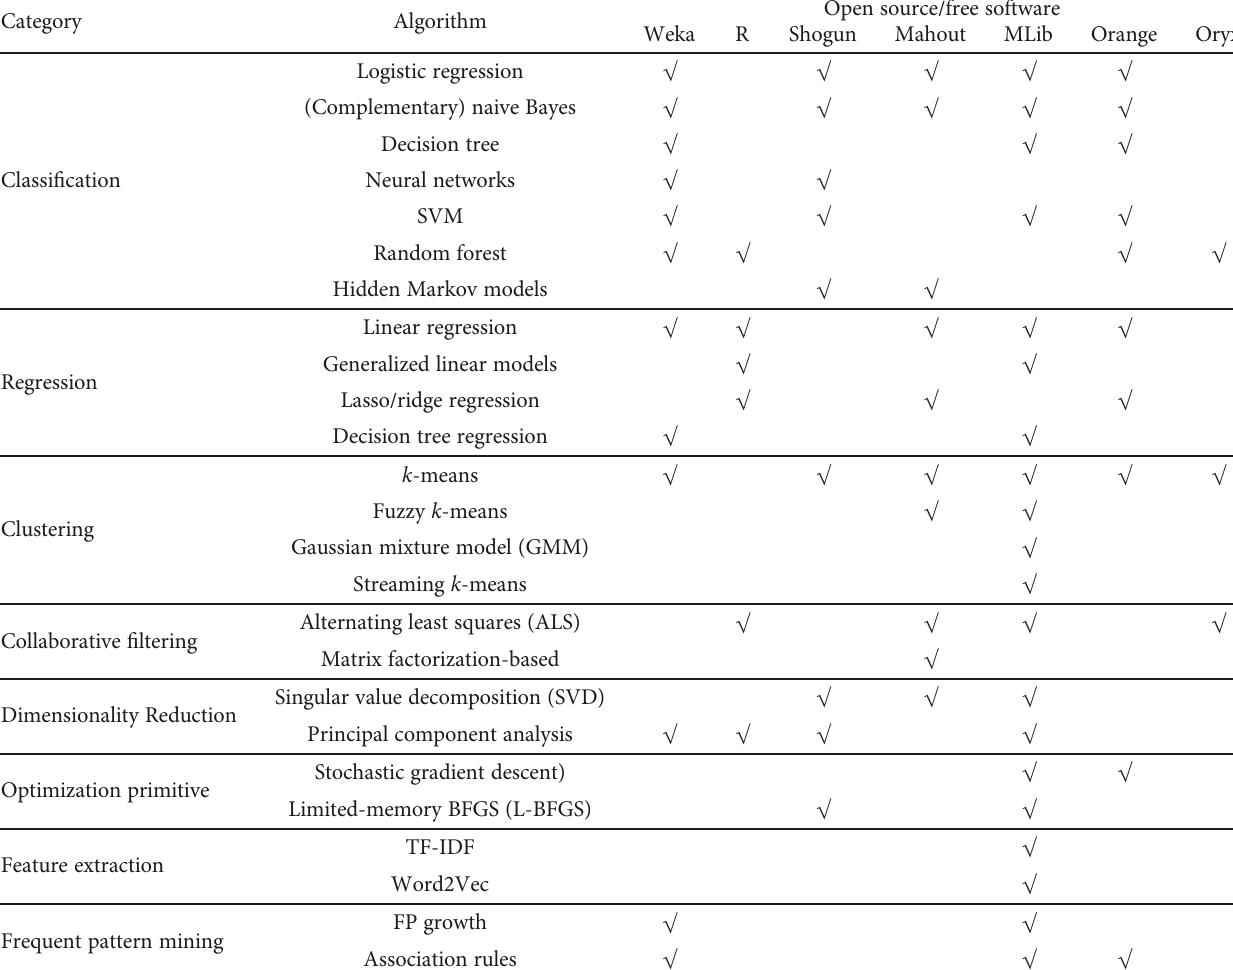
Table 2: Comparisons of open-source machine learning tools/algorithms for Big